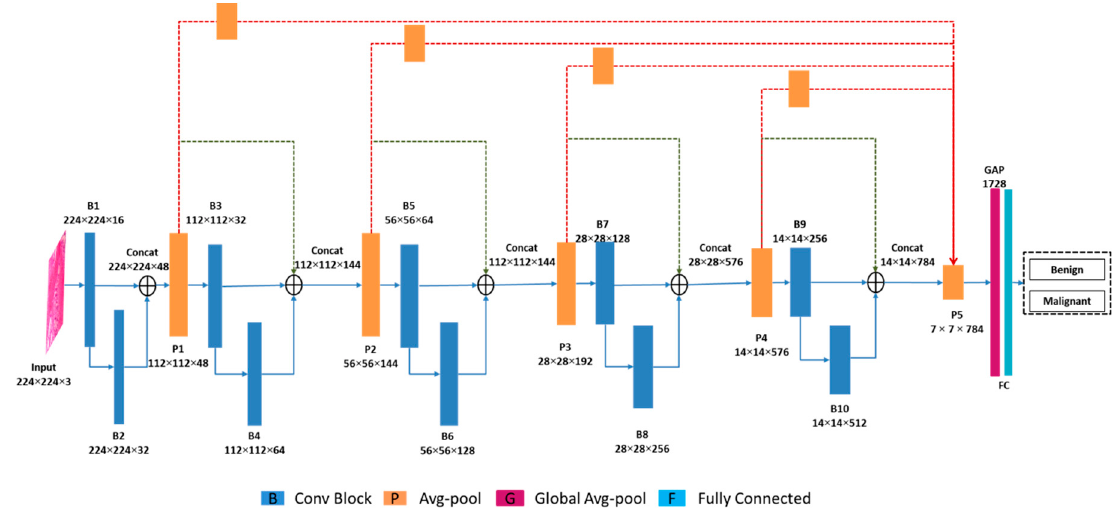
Figure 1. FabNet model: a detailed architectural overview.